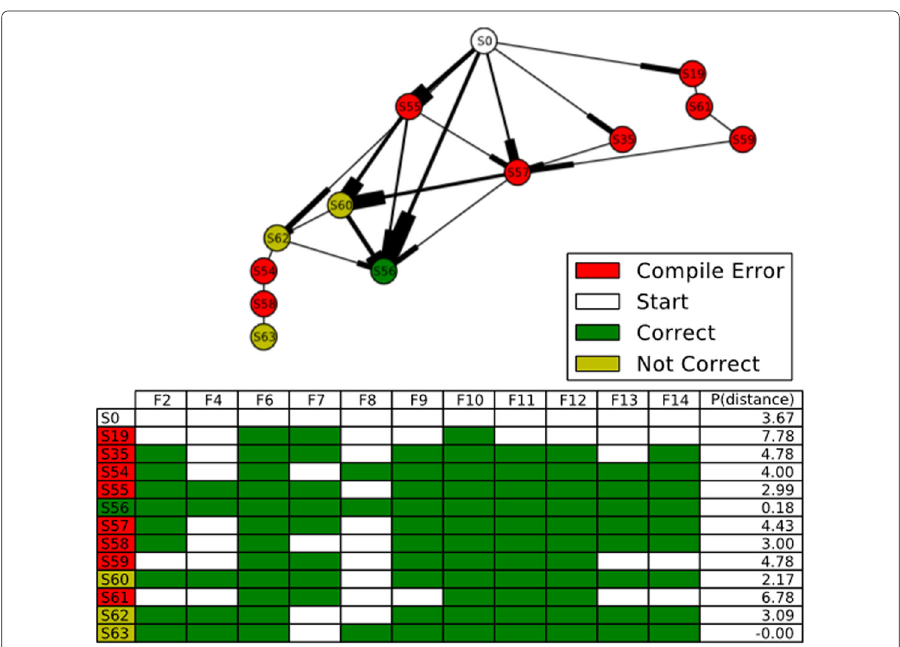
Fig. 5 An example of student program states (Sudol et al.